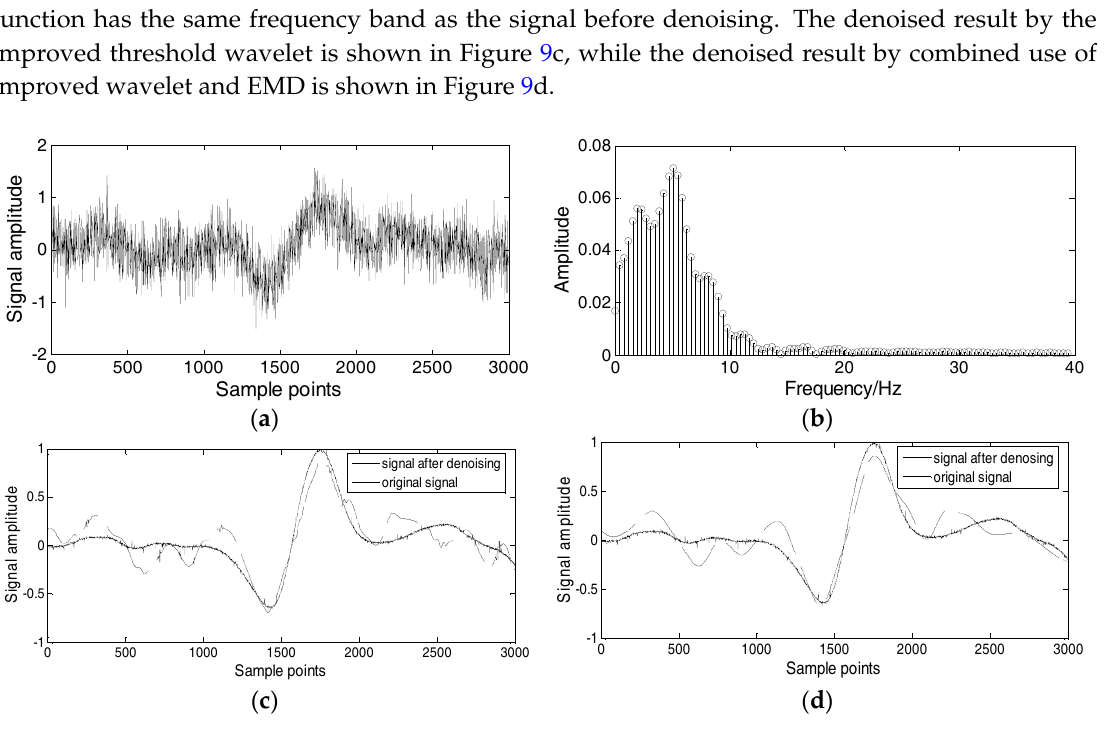
Figure 9. Comparison of two noise reduction methods for wire rope break electromagnetic signal: ( a ) Electromagnetic signal with noise of wire rope break; ( b ) Normalized spectrum diagram of wire rope break; ( c ) Denoised result by the improved threshold wavelet; ( d ) Denoised result by combined use of improved wavelet and EMD.